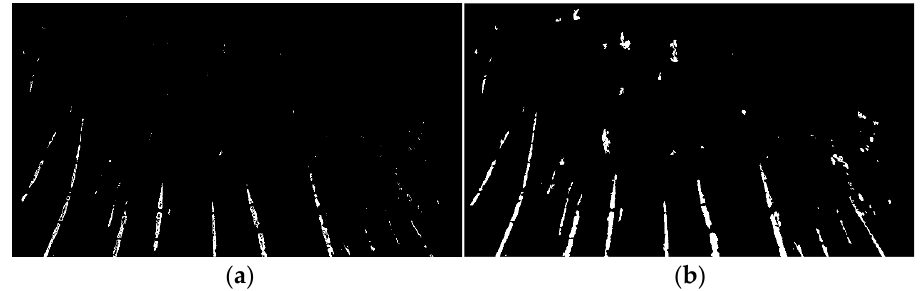
Figure 5. ( a ) Resultant seed point frame from the background removed image; ( b ) segmentation output binary frame.